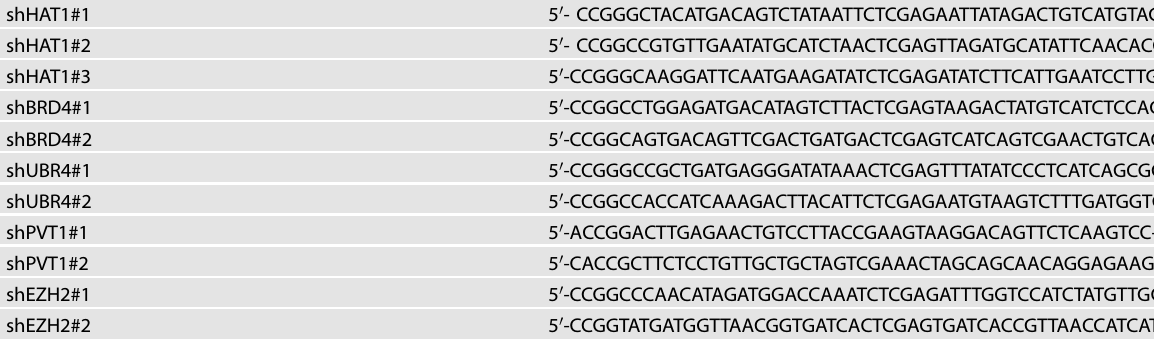
Table 1. The sequences of gene-speci fi c shRNAs.